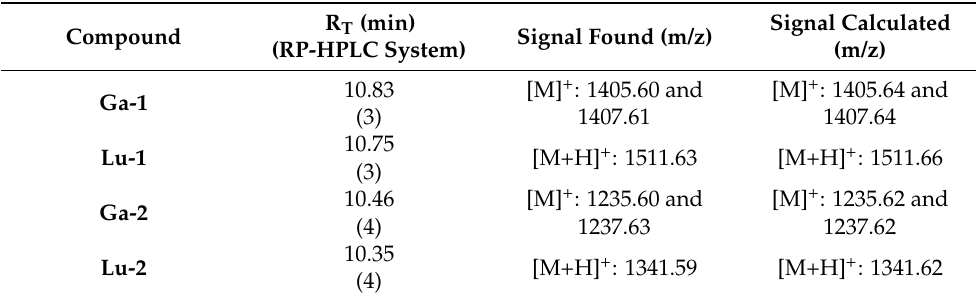
Table 3. Results of ESI-MS analyses of the synthesized cold reference compounds Ga-1 , Lu-1 , Ga-2 , Lu-2 .